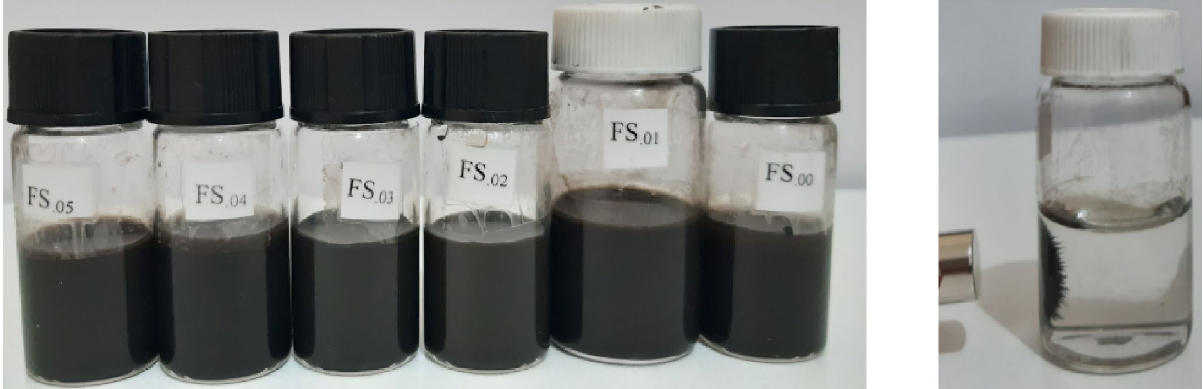
Figure 1. Images of the MNP@CA@Pluronic ferrofluid samples (left) and also showing attraction towards a magnet